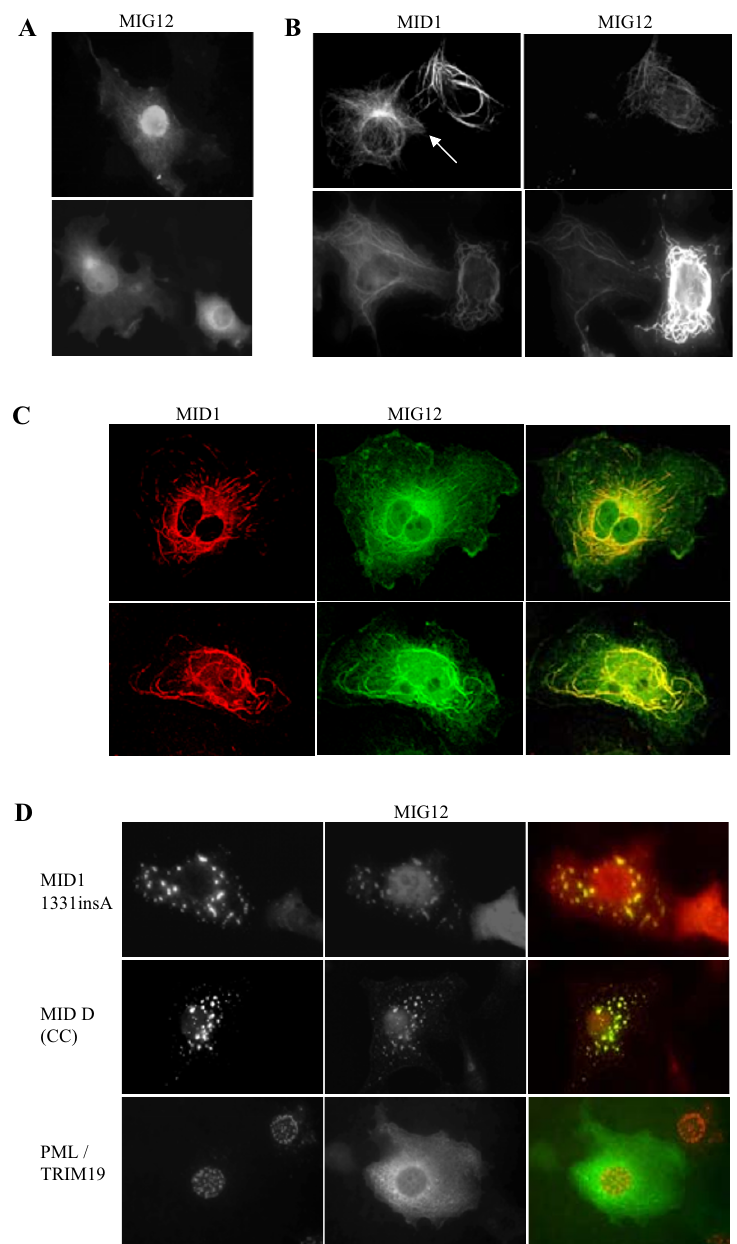
Figure 3 Immunofluorescence analyses reveal co-localization of Mid1 and Mig12 within the cell. ( A ) Immunofluorescence analysis after transient expression of MGFP-Mig12 (upper panel), HA-Mig12 (middle panel) and untagged Mig12 (lower panel) in Cos7 cells, revealing a diffuse distribution of the protein, in both the nucleus and the cytoplasm. ( B ) Co-expression of both Mid1 and Mig12 leads to co-localization of the two proteins in cytoplasmic bundles. Standard fluorescence microscopy shows formation of bundles only in Mid1 (left panels) and Mig12 (right panel) co-expressing cells. The arrow indicates a single transfected cell where Mid1 shows the classical distribution along normal interphase microtubules. ( C ) The co-localization is confirmed by confocal microscopy analysis in which HA-Mid protein is visible as a red signal and MGFP-Mig12 protein as a green signal; co- localization is indicated as a yellow signal in merged images. ( D ) Co-localization is also observed using the HA-Mig12 construct (middle panels) together with either a Mid1 OS truncated mutant (GFP-Mid1 1331insA) or a Mid1 mutant (GFP-MidD) retain- ing the coiled-coil domain, both localized in cytoplasmic bodies. No co-localization is observed when HA-TRIM19/PML protein is co-expressed with GFP-Mig12. The right panels represent the merged